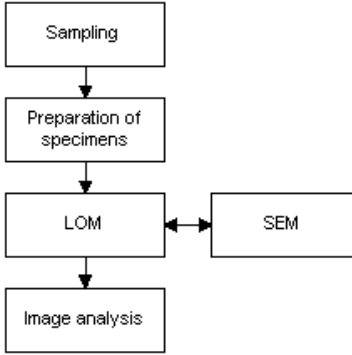
Figure 6. Method for characterization of AOD slag